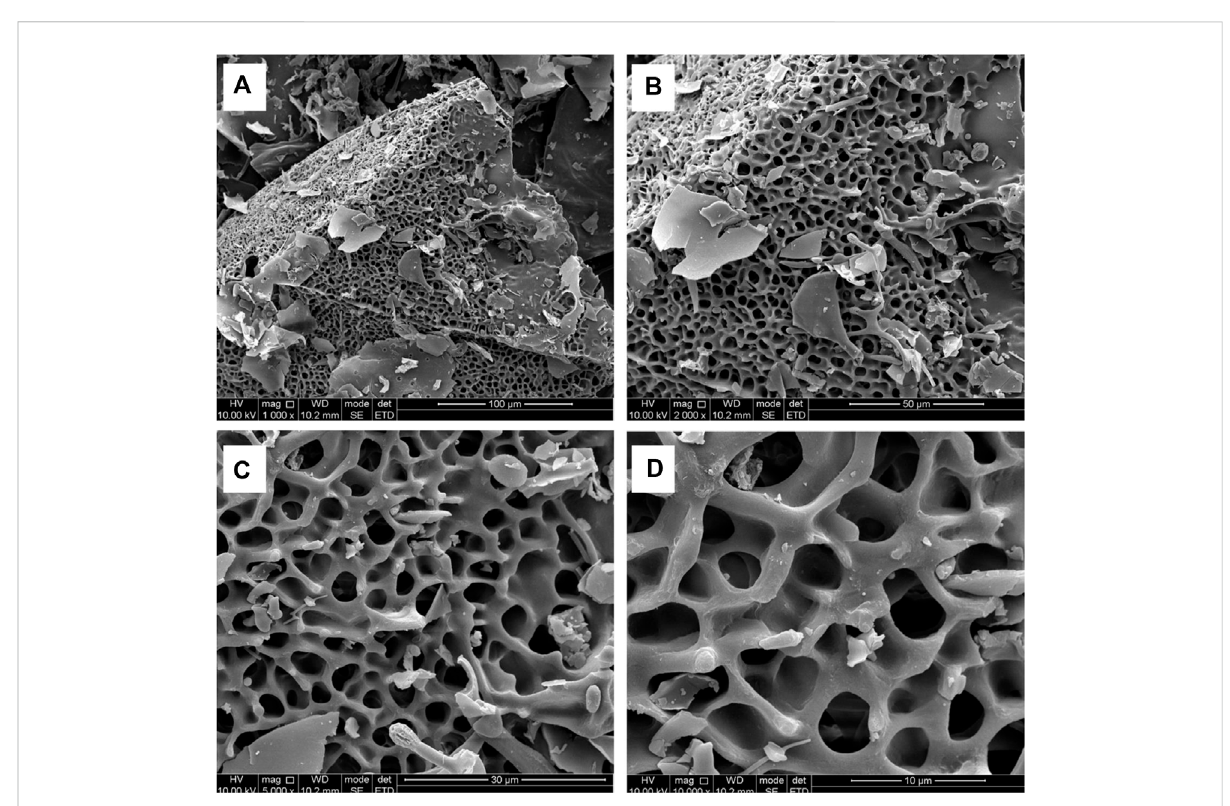
FIGURE 7 SEMobservationsshowthatRFPhasahoneycombnetworkstructurewithtightandregularcross-linking. (A) Magni fi